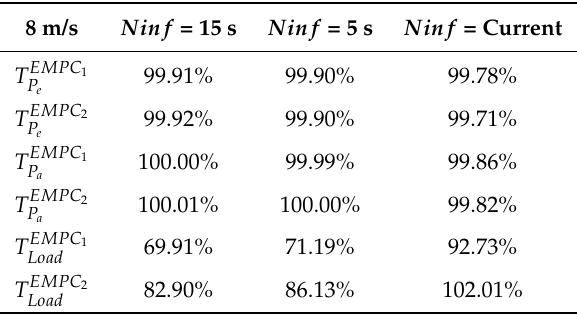
Table 7. The rate of EMPCs to MPC with a limited preview horizon at an average wind speed of 11 m/s. 11 m/s Ninf = 15 s Ninf = 5 s Ninf = Current T EMPC 1 P